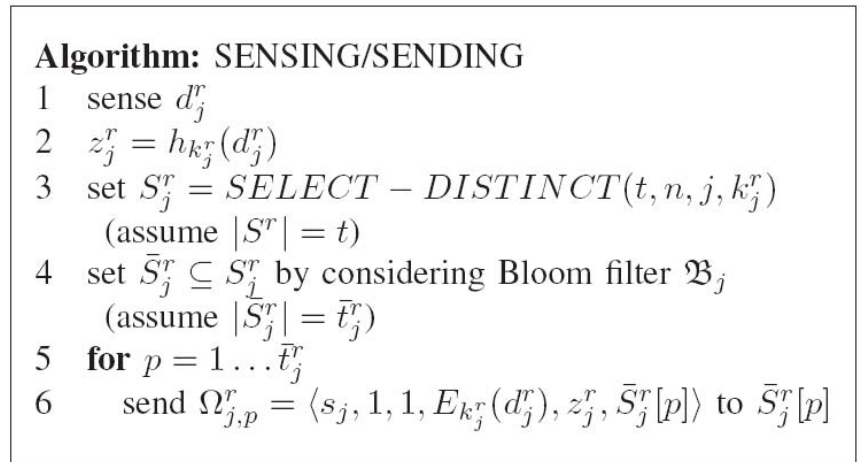
Figure 5. The algorithm of sensing